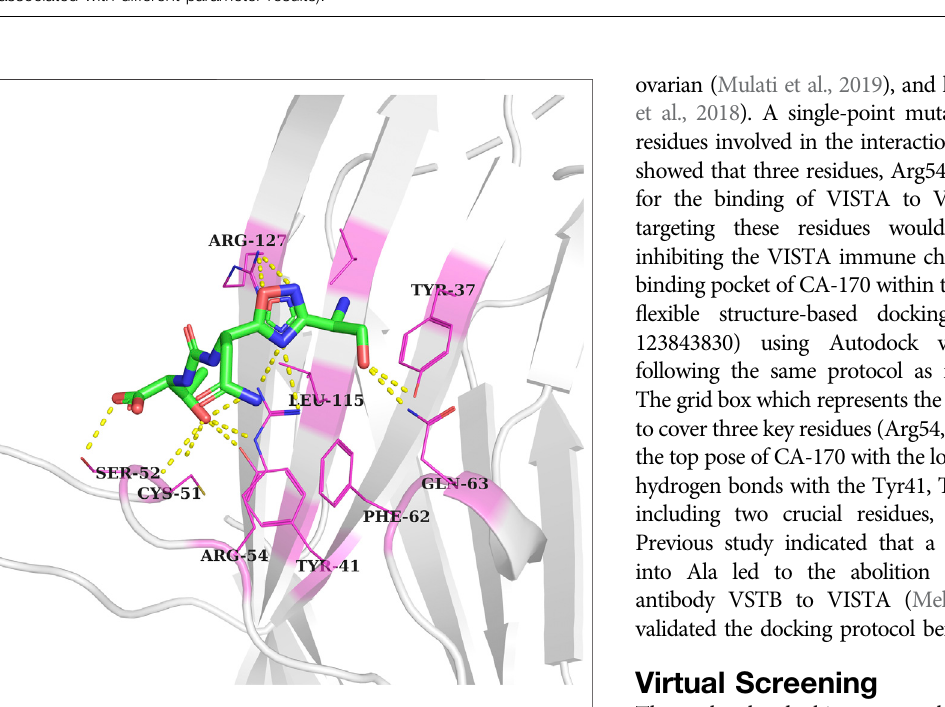
Frontiers in Molecular Biosciences |